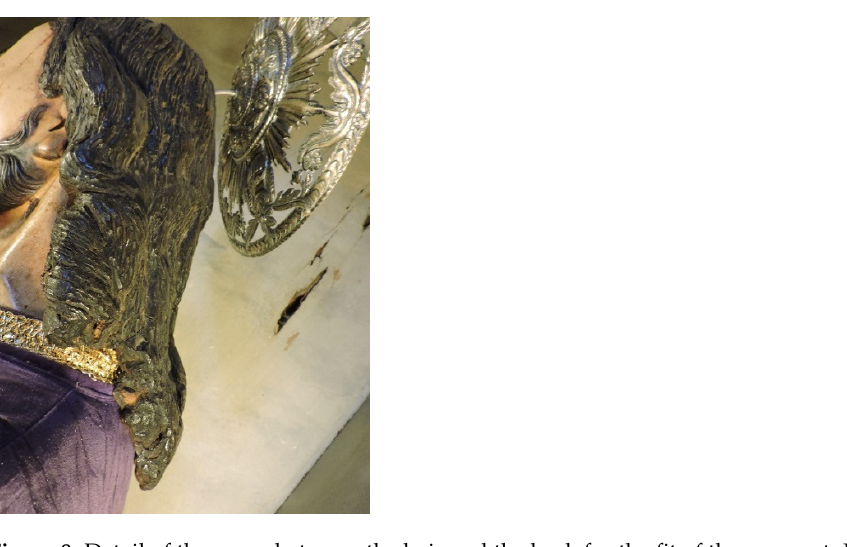
Figure 7. Pedro da Cunha. Agony in the Garden, in the Church of the Third Order of Mount Carmel in Itu. Polychrome wood sculpture (126 × 62 × 52cm), eighteenth century. Photo by Lia Brusadin, 26